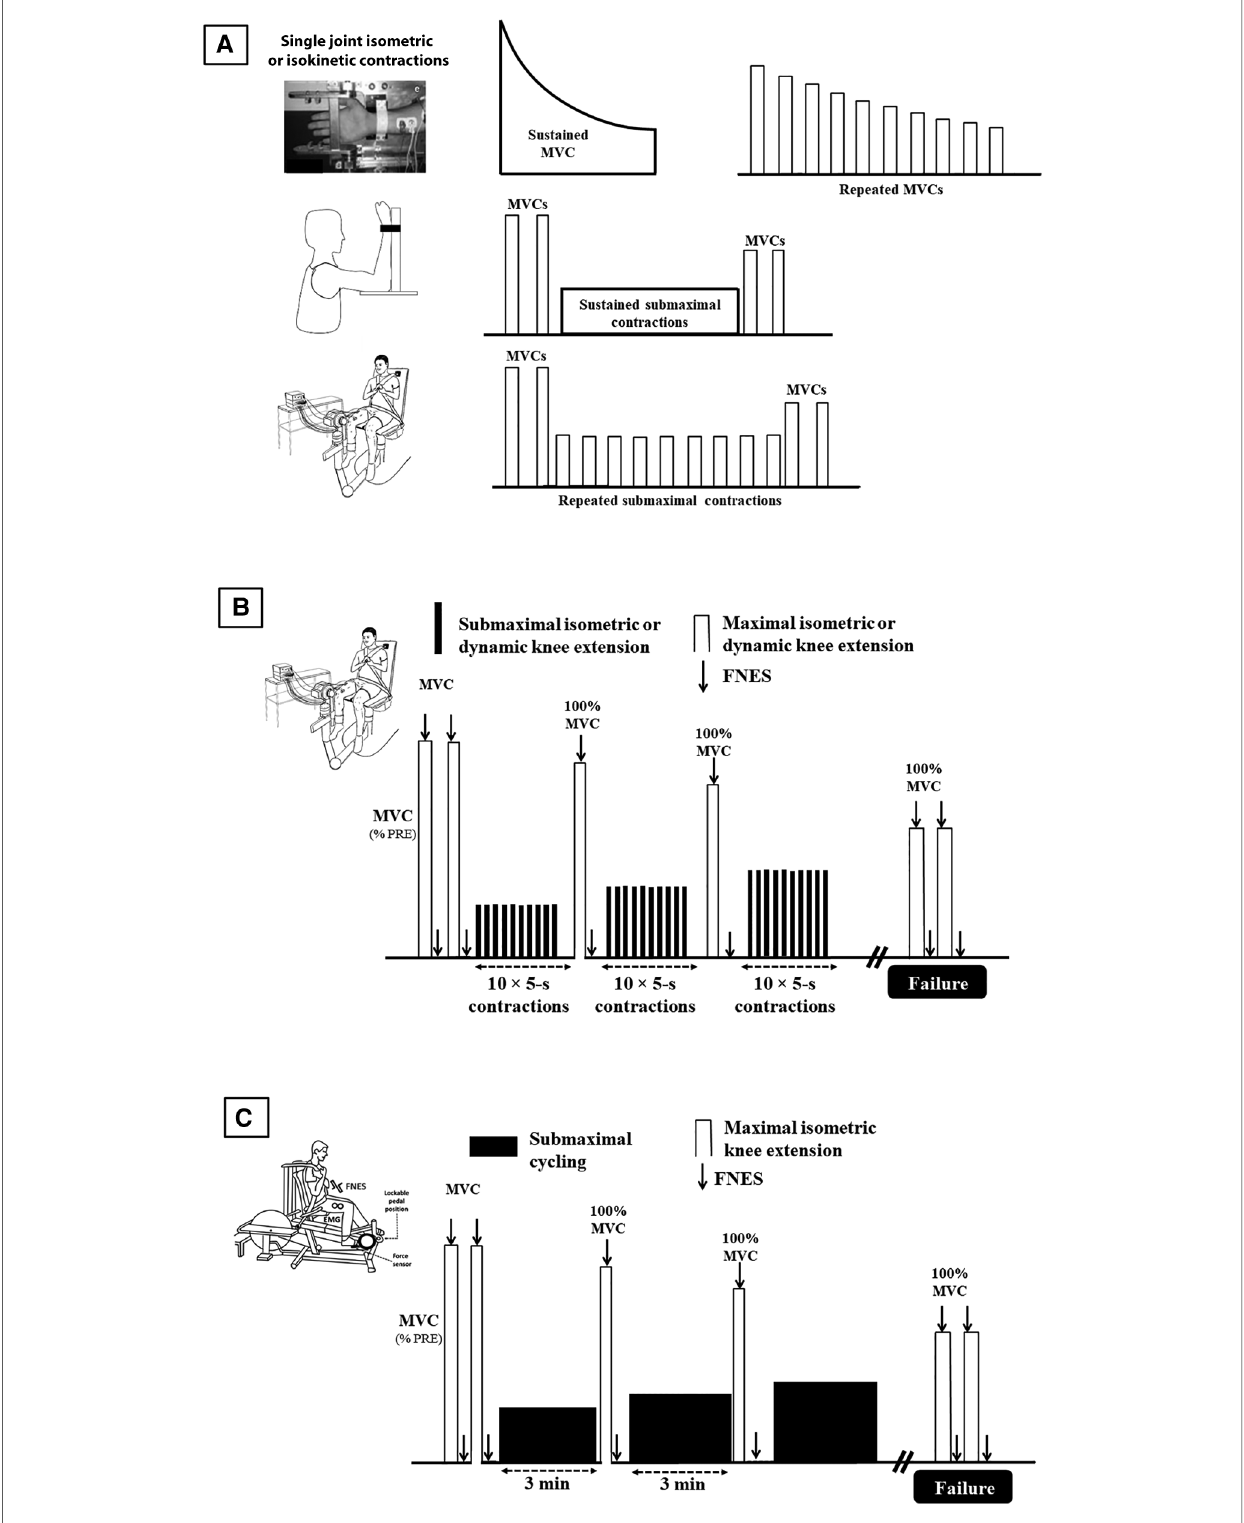
FIGURE 1 Main protocols used to assess objective fatigability, from non-speci fi c evaluations ( A ), to more ecological ones ( B ), and to highest level of ecological validity ( C ). Lower limbs protocols also involve plantar fl exor muscles, usually in isometric mode. MVC: maximal voluntary contraction; FNS: femoral nerve electrical